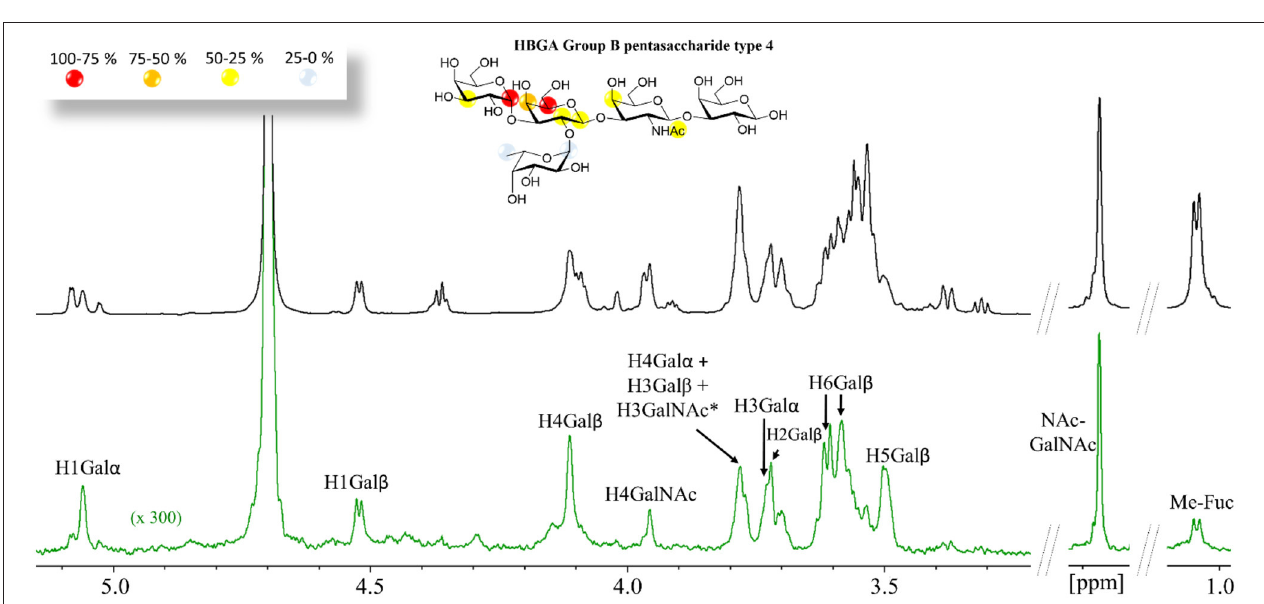
FIGURE 1 | (A) 1 H STD NMR experiment for the complex formed by the A type-6 tetrasaccharide and Gal-4N (50:1 molar ratio). Top: the reference spectrum (black, off-resonance). Bottom: the STD NMR spectrum (green, on-resonance at the aromatic region). The 1 H-NMR signals showing STD effect are annotated. The epitope mapping (relative STD) is shown in the ligand structure. (B) Details of the off-resonance and the STD NMR spectra showing the NAc region obtained for the HBGAs in the presence of Gal-4N: from left to right: A type-6, B-type-1, B-type-2, and B-type-4. Terminal refers to the terminal α -GalNAc residue. Red-end refers to the reducing-end GlcNAc or GalNAc residues. The intensities of the STD spectra are 75-fold incremented with respect to the reference off-resonance spectra.